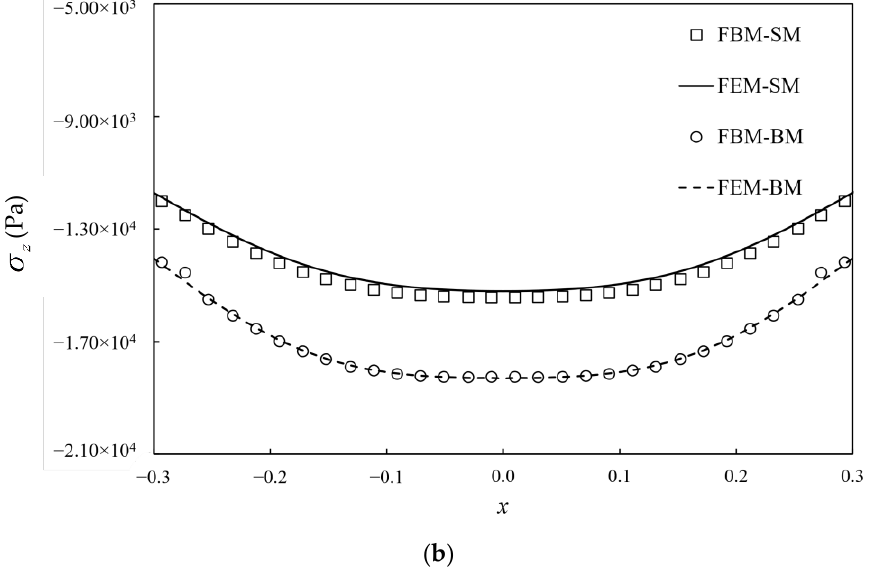
Figure 13. Stress σ z distribution and comparison with FEM on: ( a ) AB; ( b ) CD. SM indicates single Young’s modulus and BM indicates bimodular material.